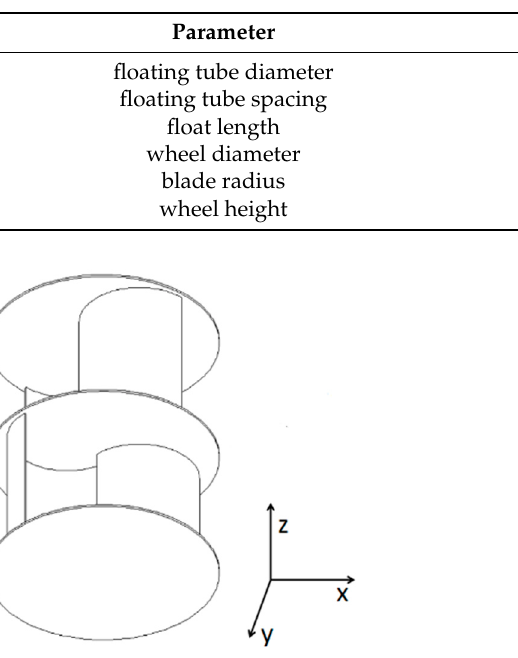
Figure 1. Savonius type runner.